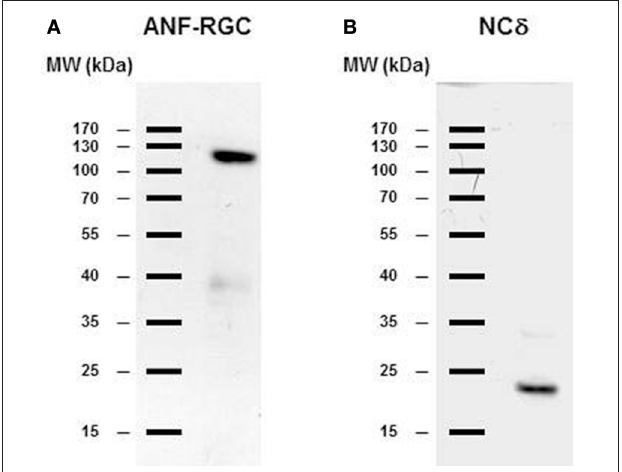
FIGURE 3 | ANF-RGC and neurocalcin δ are expressed in the mouse adrenal gland. Mouse adrenal gland was homogenized in 50mM Tri-HCl/10mM MgCl 2 buffer (pH 7.5) containing protease inhibitor cocktail (Sigma). The proteins ( ∼ 40 μ g/lane) were subject to SDS-polyacrylamide gel electrophoresis and analyzed by Western blot using antibody against ANF-RGC or neurocalcin δ as described in the “Materials and Methods” section. (A) immunoreactivity with ANF-RGC antibody. (B) immunoreactivity with neurocalcin δ